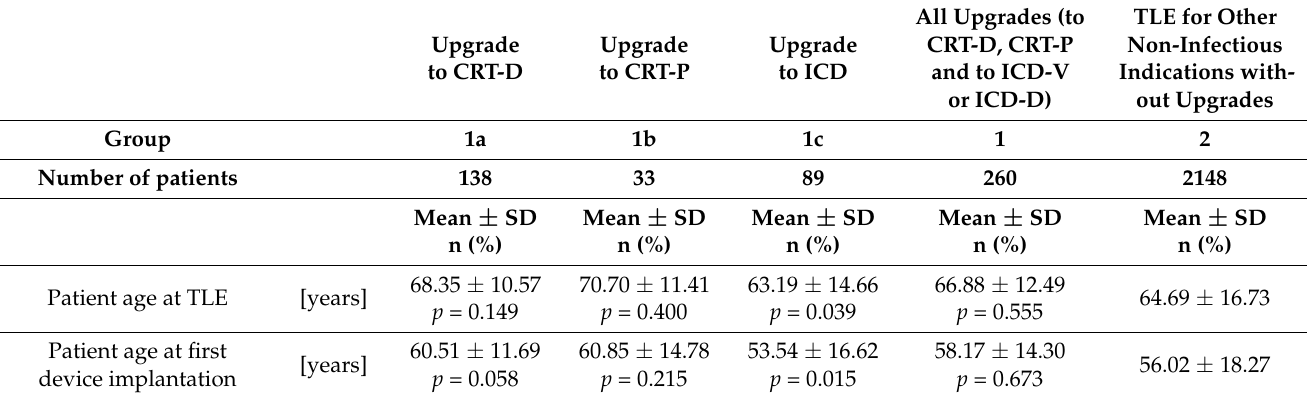
Table 1. Patient characteristics and indications for lead